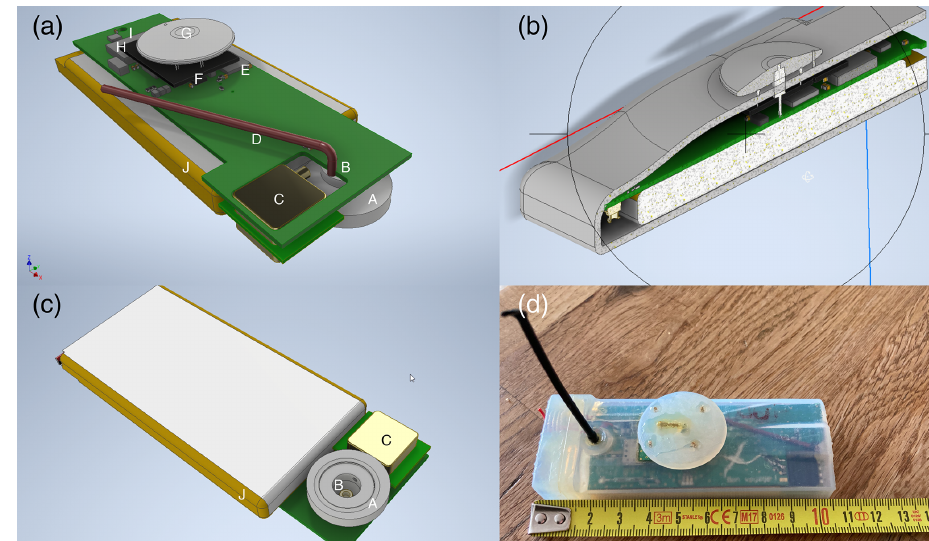
Figure 1. 3D CAD design of (a) the top of the PCB, (b) the casing, (c) the bottom of the PCB with pressure dome, and (d) a picture of the actual platform. The PCB hosts: a pressure dome (a-A/c-A), a barometric pressure sensor (a-B/c-B), a differential pressure sensor (a-C/c-C), a PEEKsil red series capillary (a-D), an accelerometer (a-F), an anemometer (a-F) with the heating element (a-G), a microcontroller (a-H), a GPS (a-I), and a lithium battery